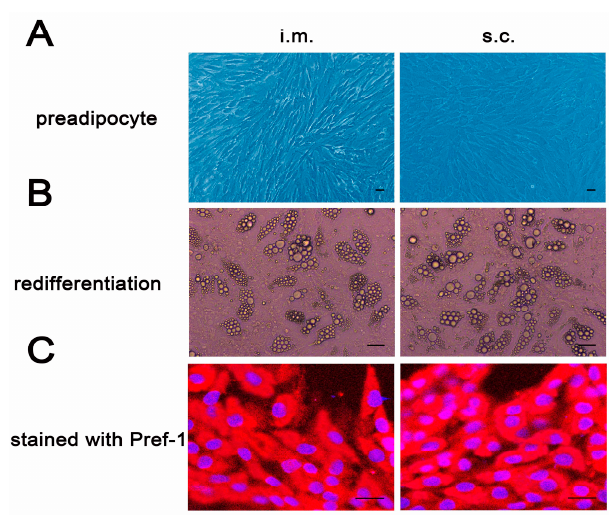
Figure 1. Identification of porcine i.m. and s.c. preadipocytes. The dedifferentiated porcine intramuscular (i.m.) and subcutaneous (s.c.) preadipocytes showed fibroblast-like morphology ( A ); The i.m. and s.c. preadipocytes were induced in adipogenic medium at confluence. Nine days later, the i.m. and s.c. preadipocytes were re-differentiated to mature adipocytes with lipid droplets ( B ); The isolated i.m. and s.c. preadipocytes were seeded in 12-well plates, and the cells of day 3 were detected by Pref-1 immunofluorescent staining ( C ). Scale bar = 100 μ m.